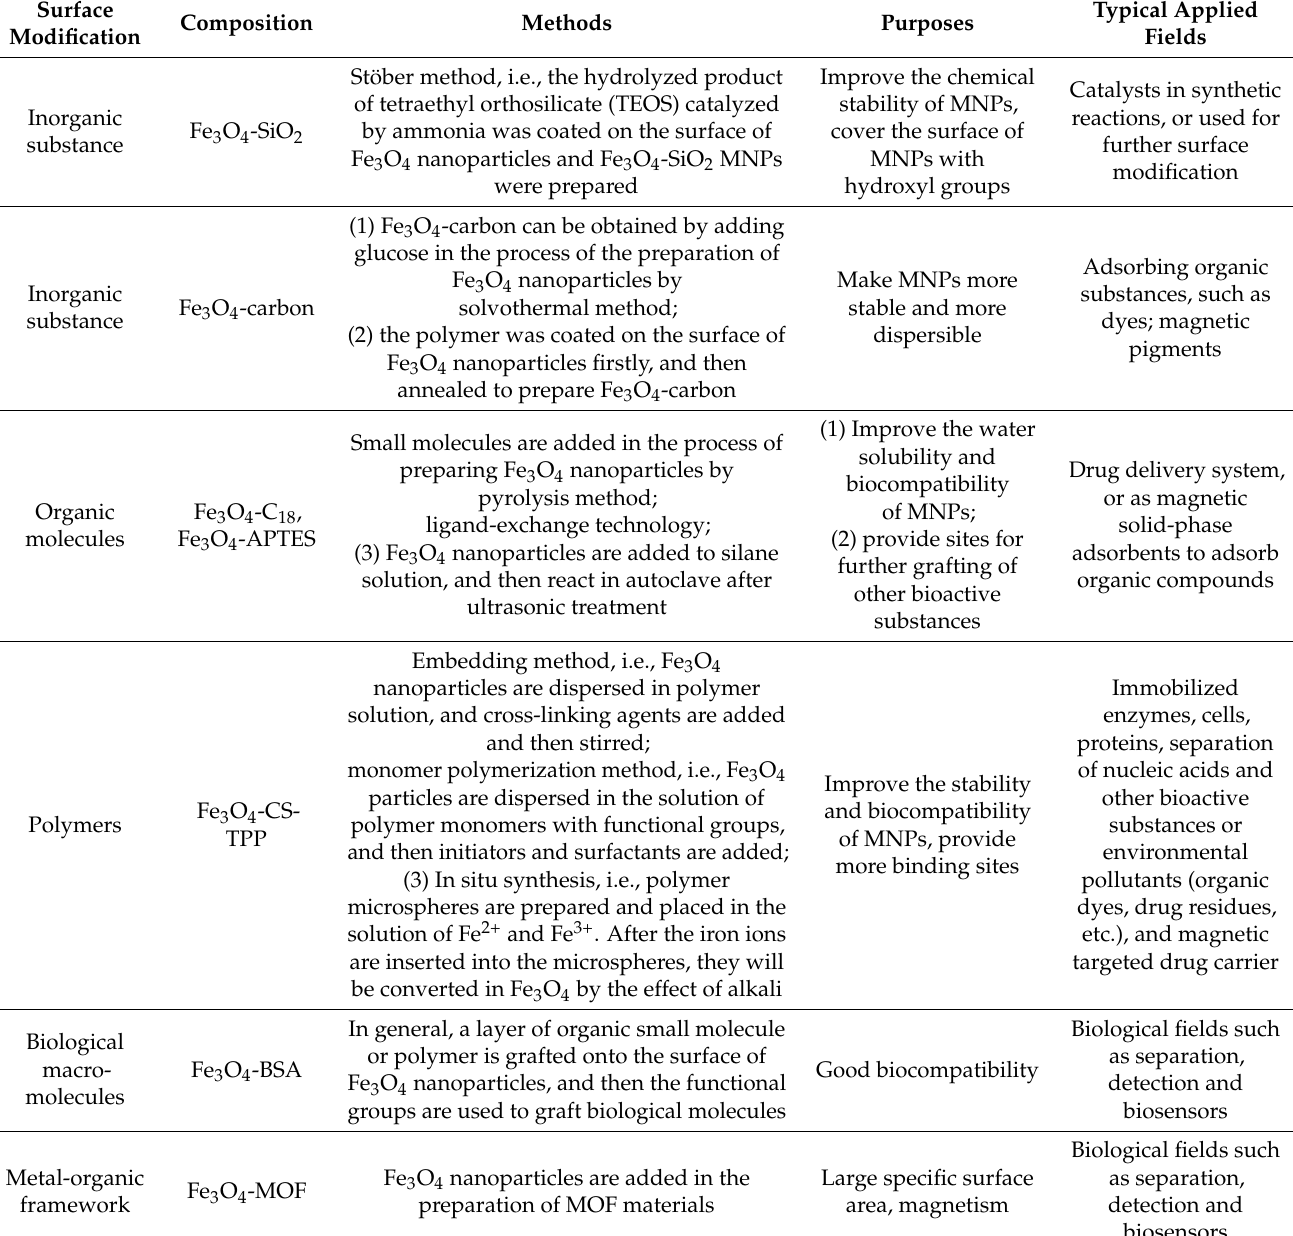
Table 2. Magnetite nanoparticles and their surface